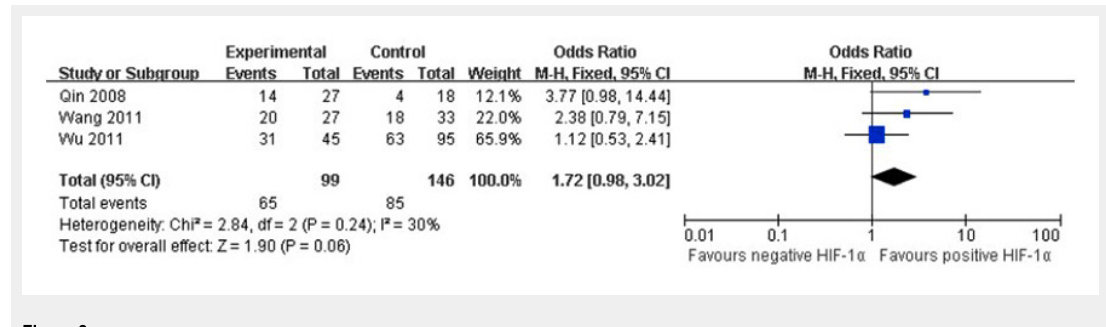
Figure 3 Forest plot of COX-2 positive expression in positive and negative HIF-1α tumour